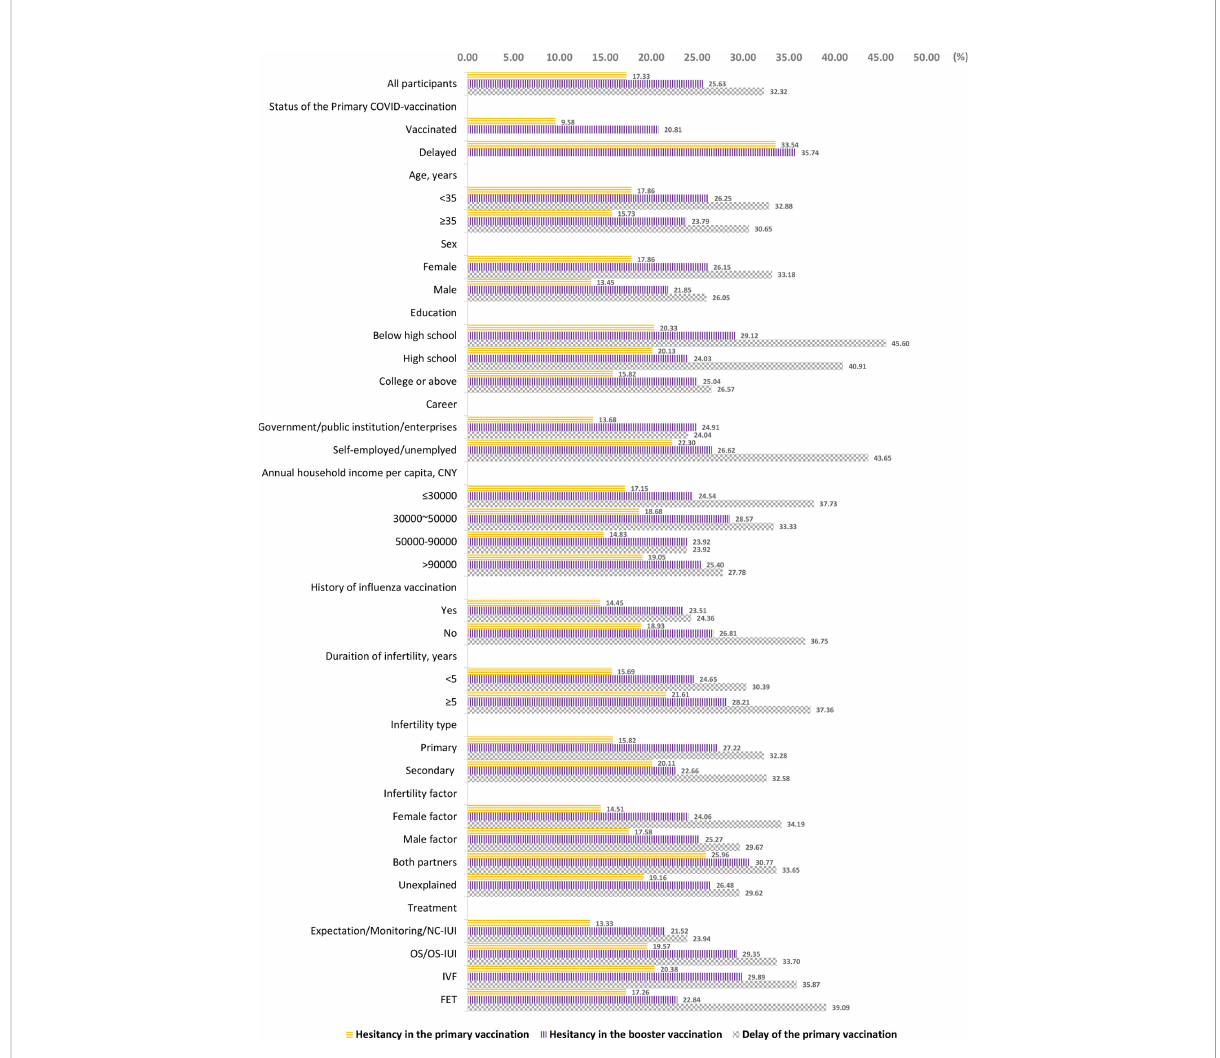
FIGURE 1 Prevalence of COVID-19 vaccine hesitancy and delay of the primary